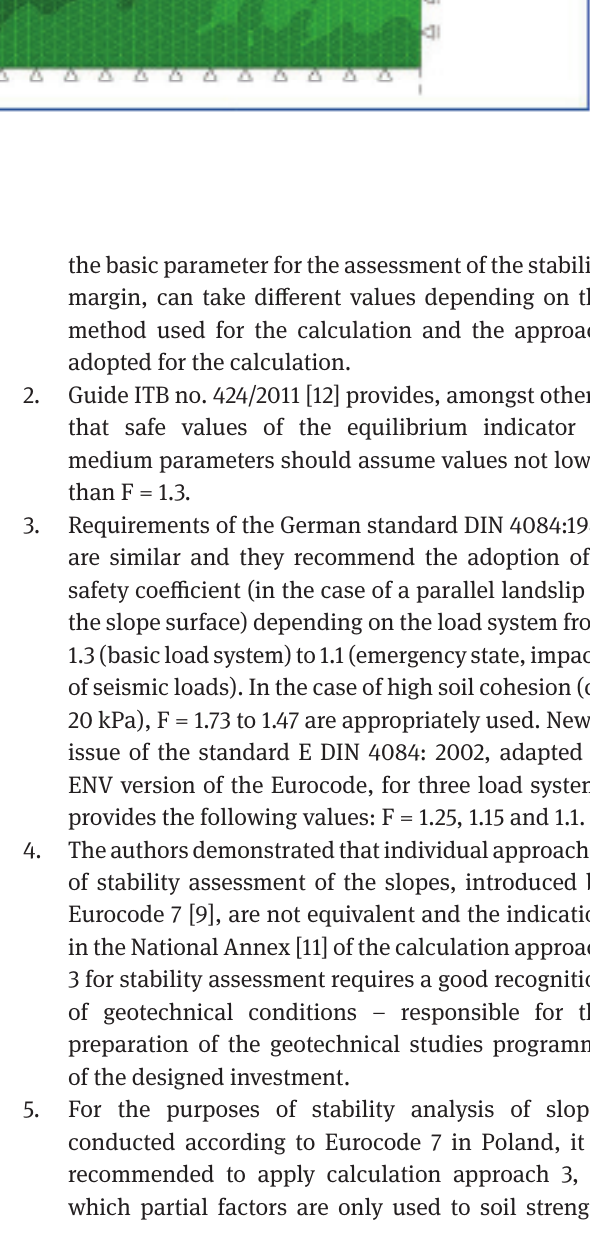
Figure 14: Results of stability calculations of the slope F